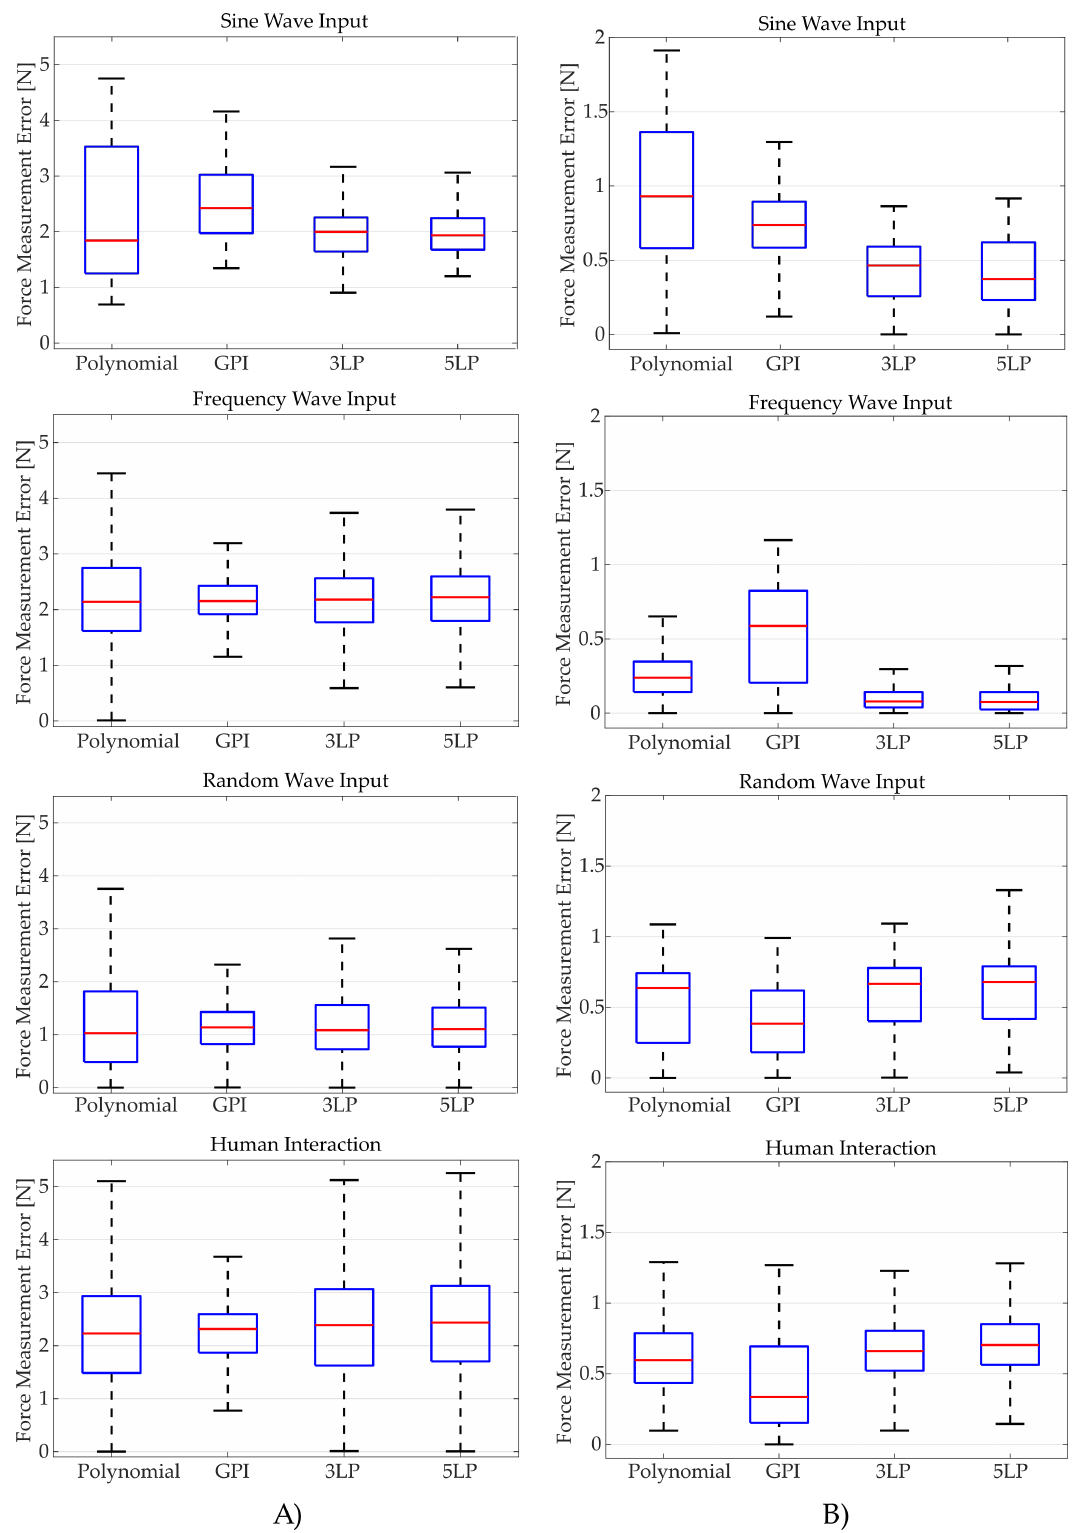
Figure A2. Error distribution computed for each tested kind of signal and model, where ( A ) corresponds to the data of the PLA based sensor and ( B ) to the steel based